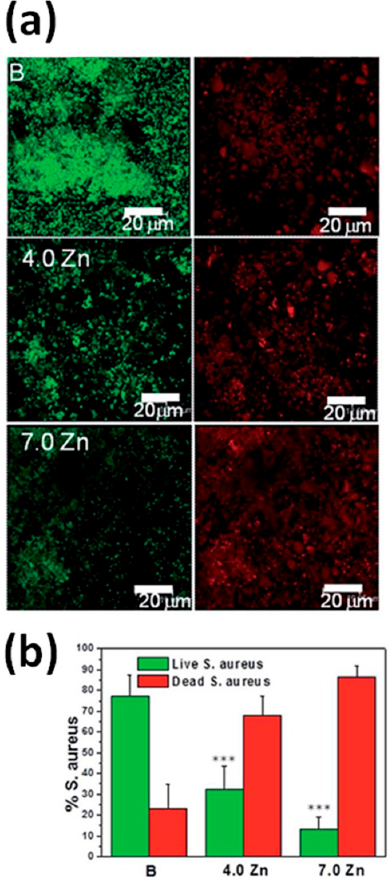
Figure 17. ( a ) Representative confocal micrographs of S. aureus biofilms formed on mesoporous glass scaffold surfaces after being soaked for two days in Todd-Hewitt Broth (THB) medium. Viable (green) and non-viable (red) bacteria are shown; ( b ) The percentages of the surface area covered with dead and live bacteria were calculated using ImageJ software (National Institute of Health Bethesda, MD, USA). The assay values shown are mean ± standard error. *** Significantly different compared to bare (B) scaffolds ( p < 0.005). Reproduced with permission from reference [106]. Copyright (2014) Royal Society of Chemistry.